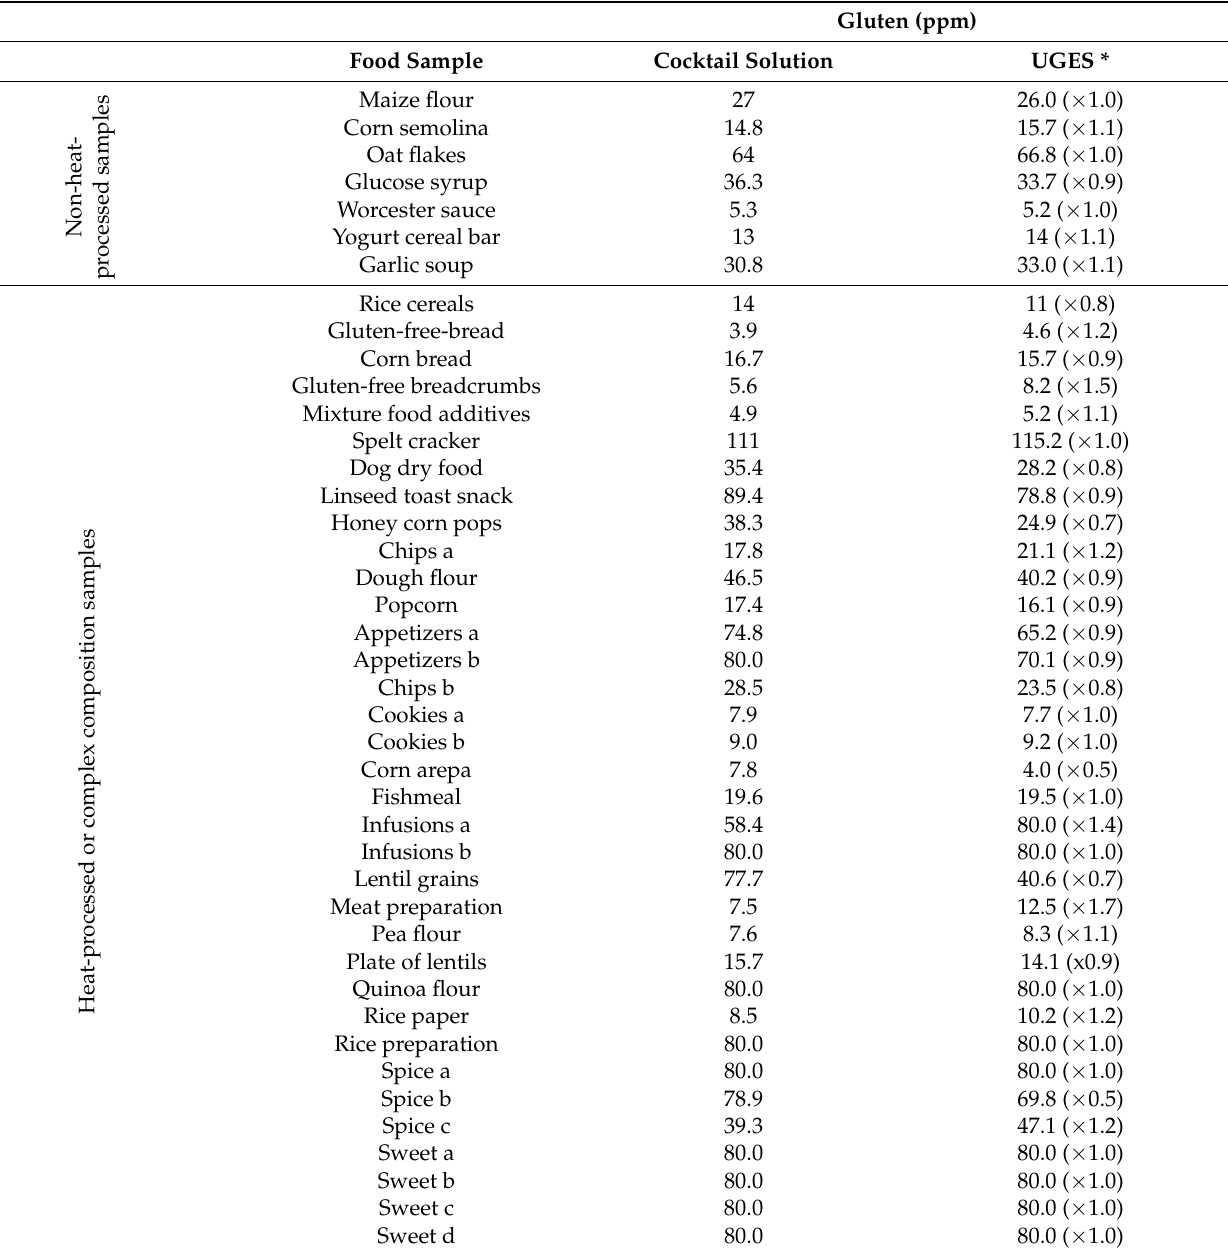
Table 3. Gluten content in ppm (mg/kg) of different samples by sandwich ELISA with Cocktail solution and Universal Gluten Extraction Solution